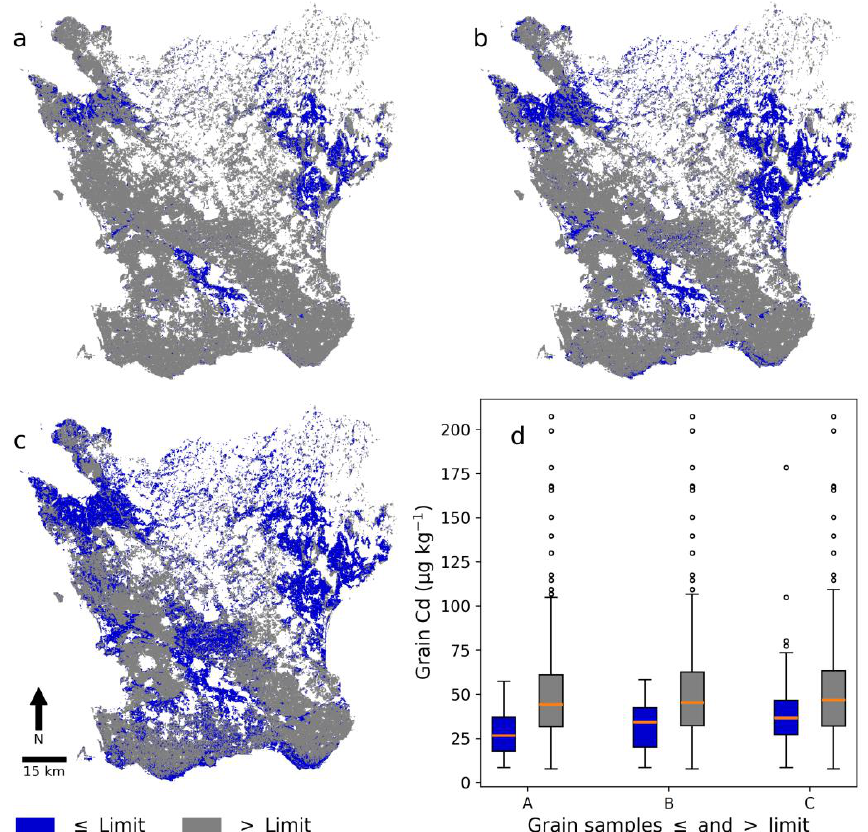
Figure 6. ( a – c ) Areas in the digital soil map (DSM) with cadmium (Cd) concentrations below (blue) and above (grey) three different limits and ( d ) box-and-whisker plots of Cd concentration in winter wheat grain in these areas. The limit in ( a ), ( b ), and ( c ) was set at 0.196 mg kg − 1 , 0.215 mg kg − 1 , and 0.240 mg kg − 1 , respectively, which corresponded to the 30th, 40th, and 50th percentile of laboratory- analyzed soil Cd concentrations in the NV dataset. The numbers of winter wheat grain samples in blue boxes and whisker plots A, B, and C are 17, 34, and 75 from a total of 307. Dots represent outliers, the orange line the median, the box the interquartile range (IQR), and the whiskers the highest/lowest data point within the IQR ×